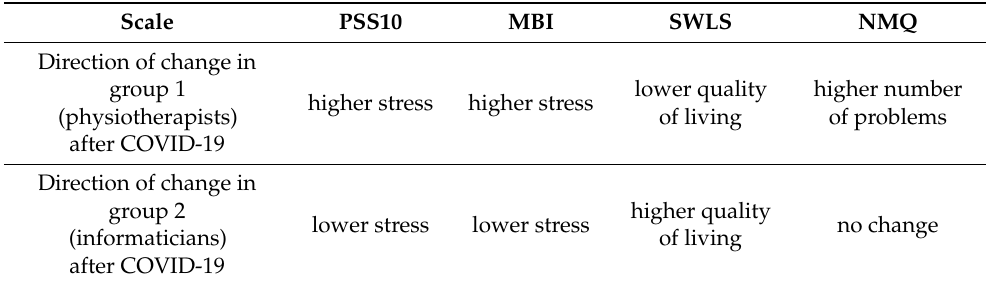
Table 3. General multivariate results in the study (only statistically significant changes